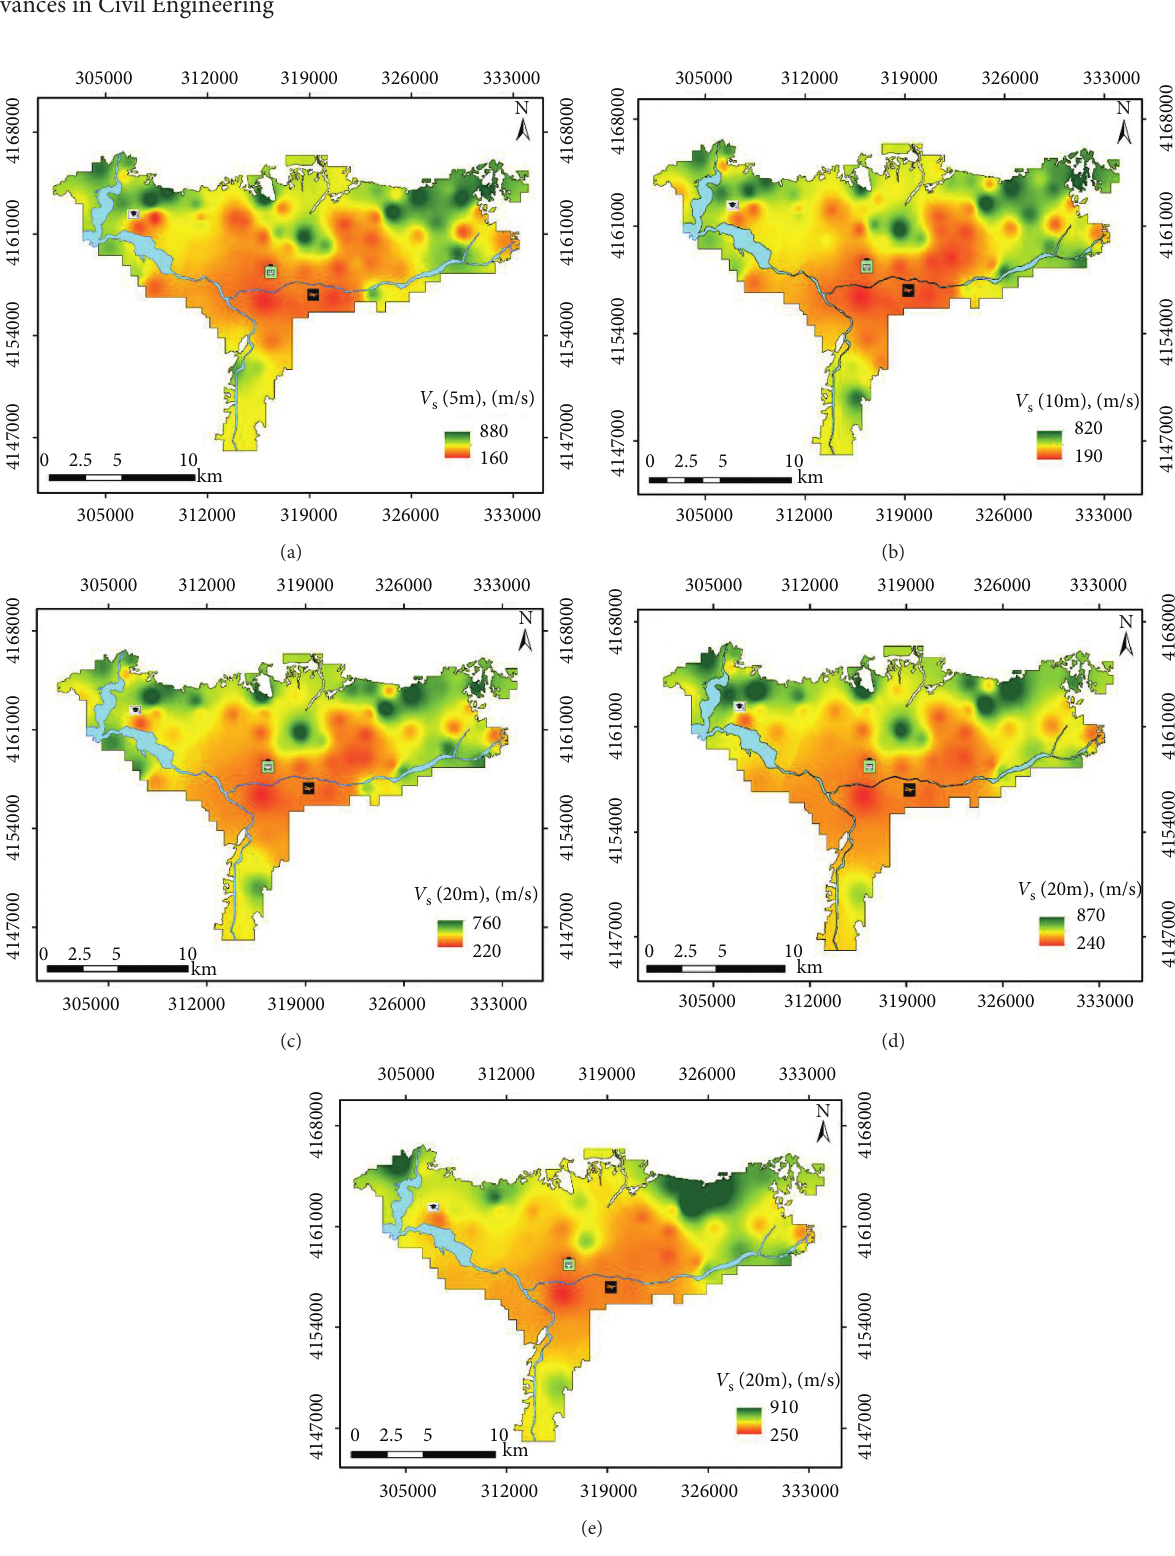
Figure 7: Average V S values for the depths of (a) 5m, (b) 10m, (c) 15m, (d) 20m, and (e) 25 m in Kahramanmaras